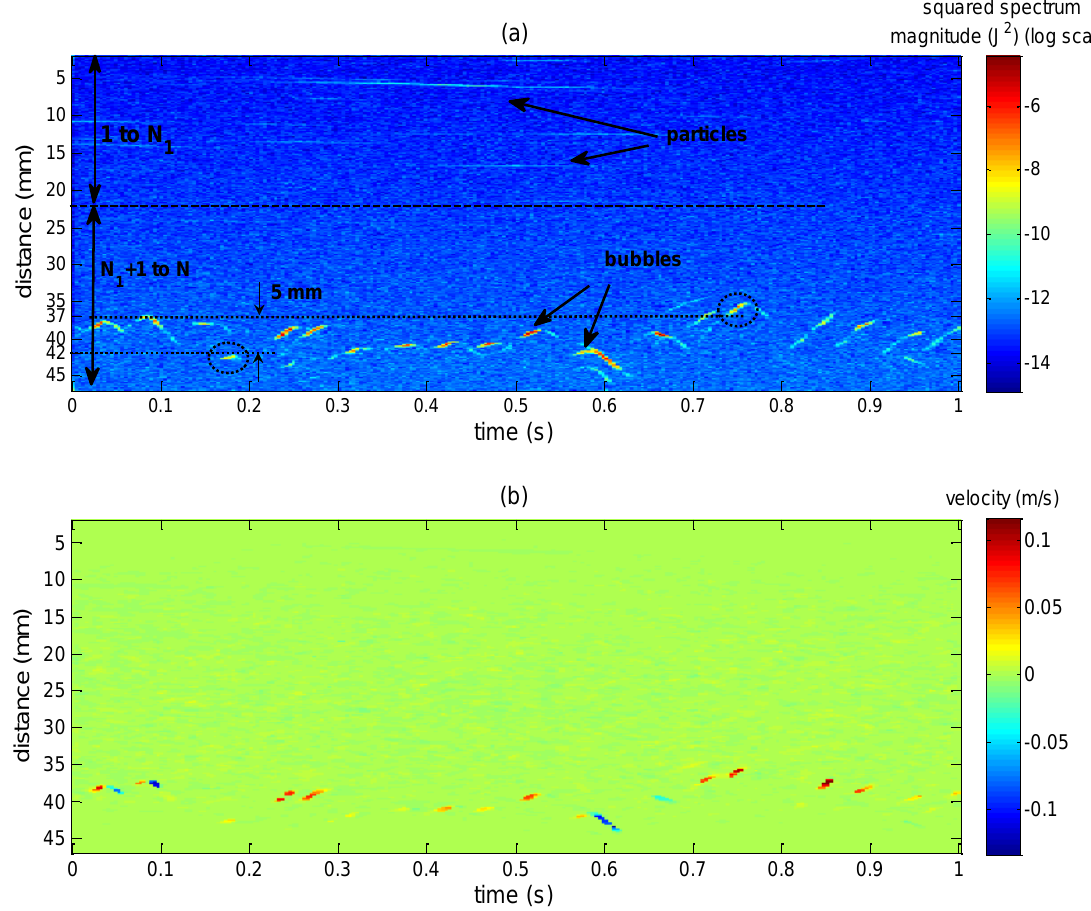
Figure 7. Example of squared spectrum peak distribution and corresponding velocity map. ( a ) The division of the spatiotemporal map in half by spatial dimension for SDR computation is showed for 1 second of acquisition build with squared spectrum peak. ( b ) Velocity distribution where bubbles are characterized by high values of velocity (0.1 m/s and −0.1 m/s) and particles near the transducer that are highlighted in (a) cannot be seen in (b) because they present null